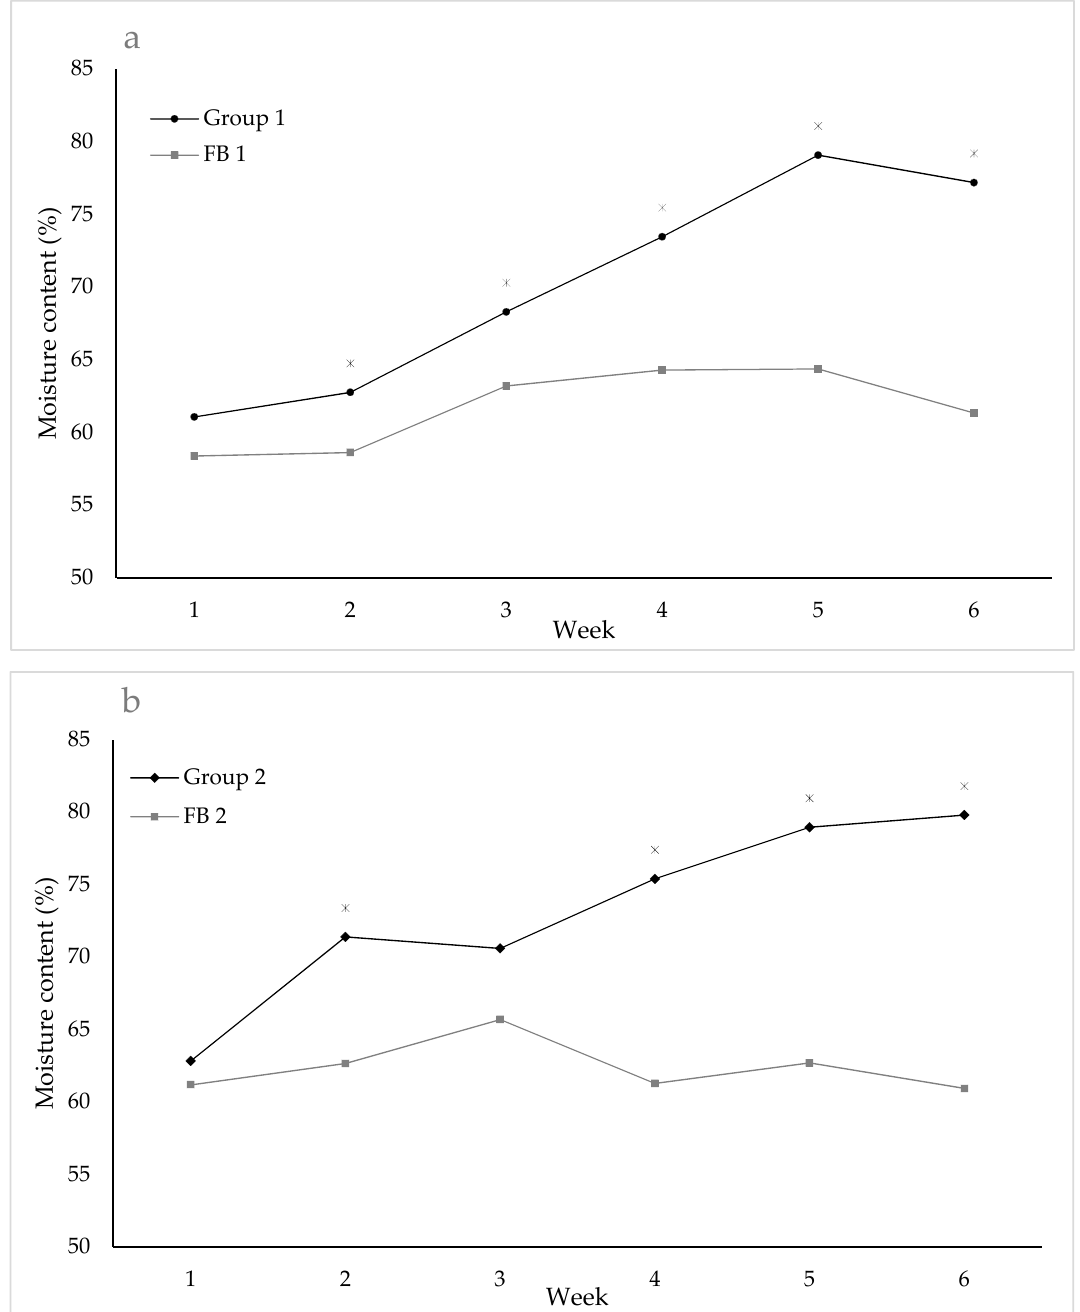
Figure 4. Mean moisture content (%) of the bedding for NFP Group 1 and FB 1 ( a ) and NFP Group 2 and FB 2 ( b ) (* indicates significance, p < 0.05, between the groups at each time point) over the five weeks of the trial.